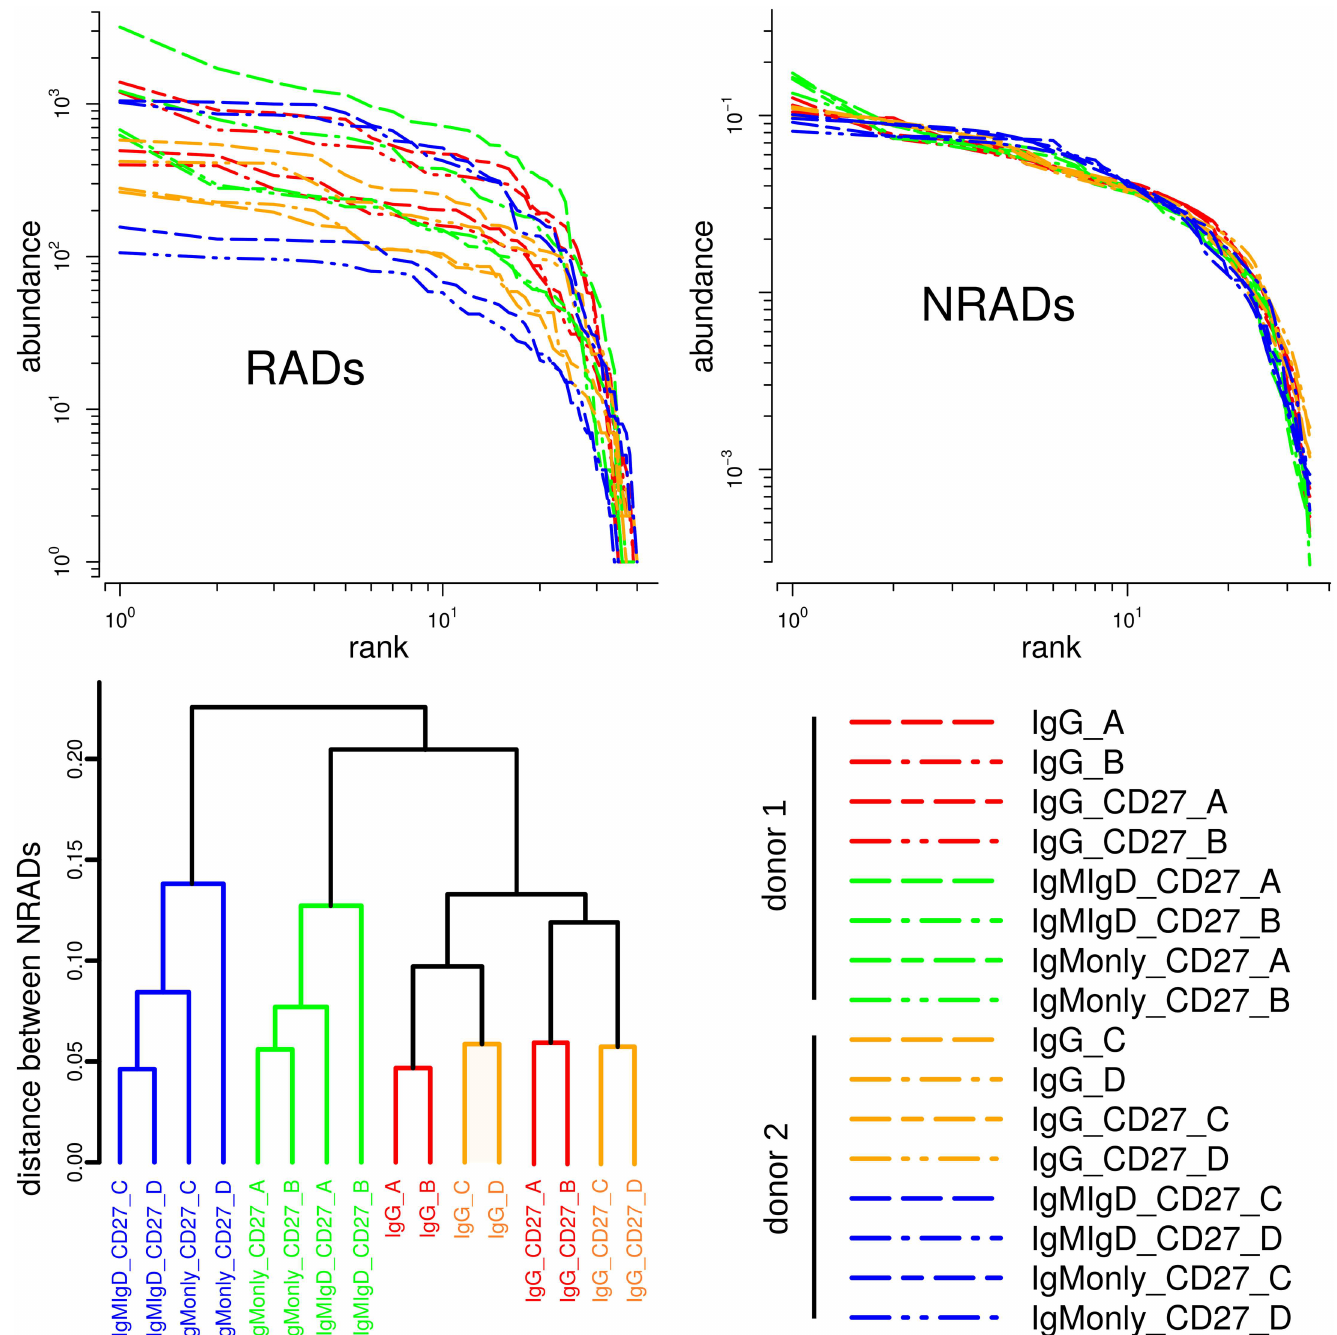
Fig 4. Rank abundance distributions of memory B cell receptors. Four different B cell receptor sub-classesfrom donors 1 (replicate samples A, B) and 2 (replicates C, D) are compared. Top left panel:Log-logplot of RADs prior to normalization. Top right: Log-logplot of correspondingNRADs. Legend for RADs and NRADs is given in bottom right panel.Bottom left: Hierarchical clustering tree basedon all pairwise distancesbetweenthe 16 NRADs.